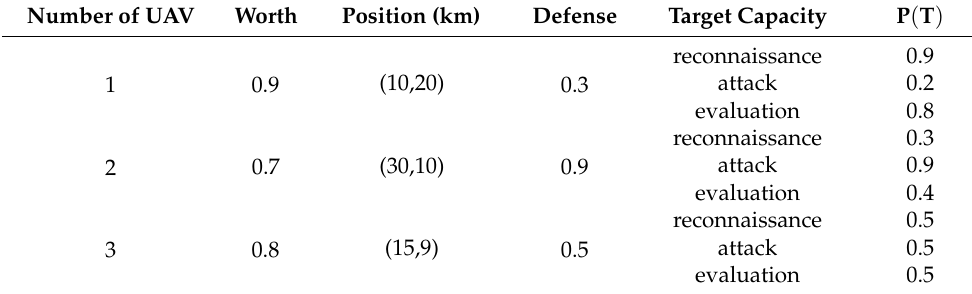
Table 5. Performance parameters of three UAVs.